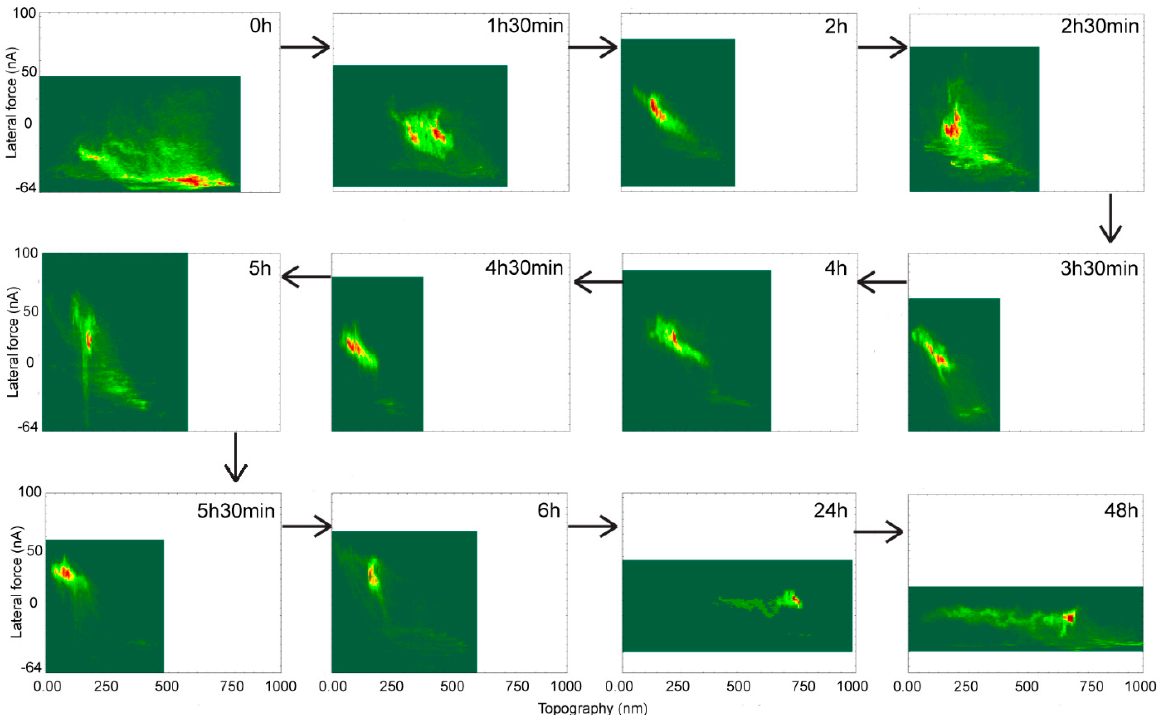
Figure 7. Sequence of double histograms of topography-lateral force readings at various stages of hydrophobic recovery.